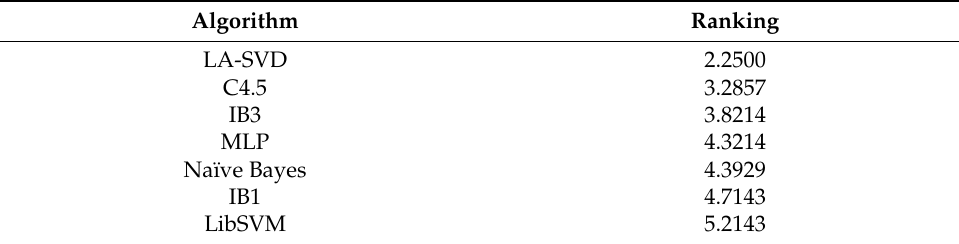
Table 7. Ranking obtained by the Friedman